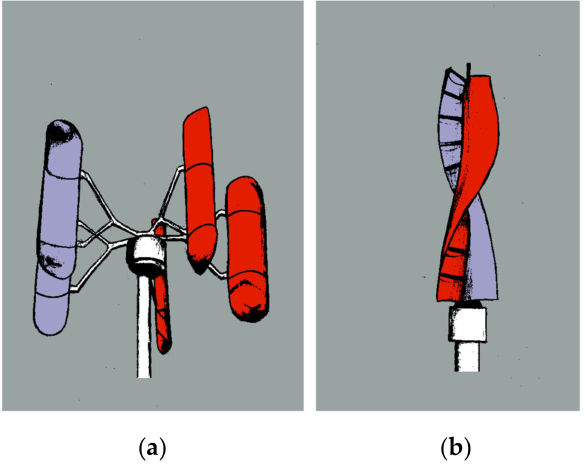
Figure 2. Turbines using drag force; ( a ) VAWT with drag elements; ( b ) Savonius